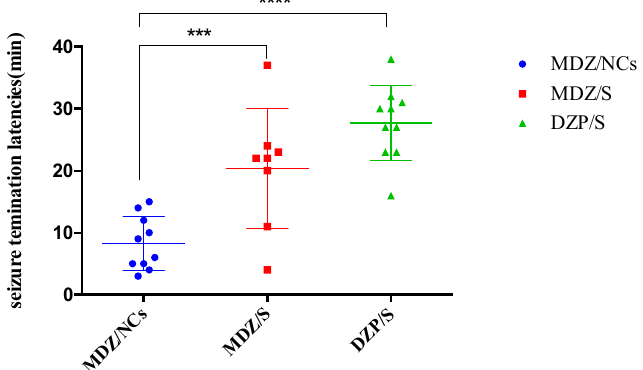
Figure 10. Convulsion latency time of the different formulations. Note: **** p < 0.0001, MDZ/NCs vs. DZP/S; *** p < 0.005, MDZ/S vs. DZP/S; * p < 0.05, MDZ/NCs vs. MDZ/S.